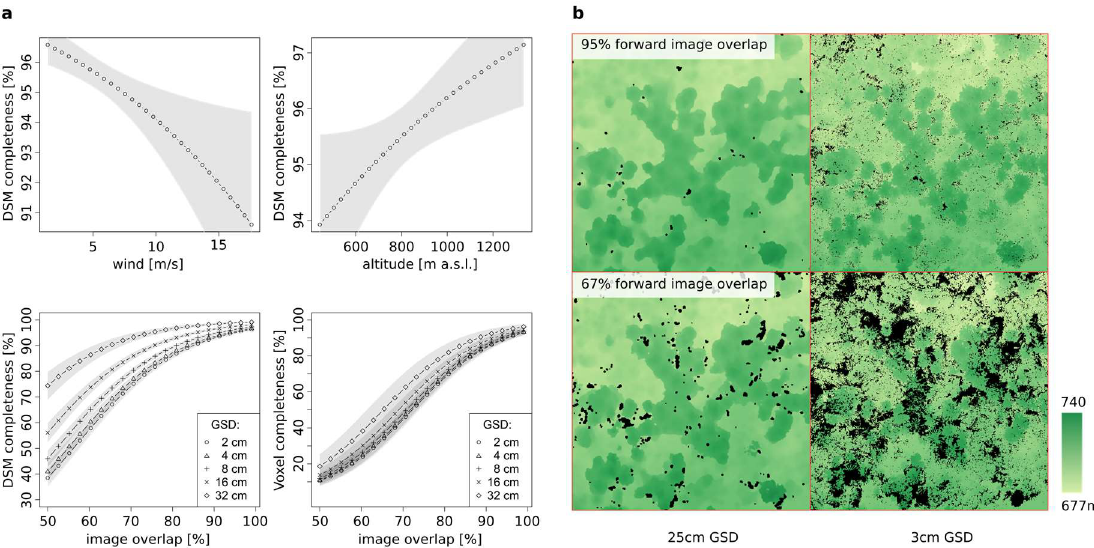
Figure 5. ( a ) Effect plots of statistical model parameters on SfM-model completeness. Plots in the upper quadrant refer to the model on the full dataset, while the lower quadrant refers to the experimental dataset. Grey areas illustrate the 95% confidence intervals. ( b ) Visualization of rendered DSMs of one experimental plot with 25cm GSD (left quadrant) and 3cm GSD (right quadrant). Forward overlap of 95% (upper quadrant) and 67% (lower quadrant). Lower altitudes appear yellow, higher in green. Black pixels indicate missing values.